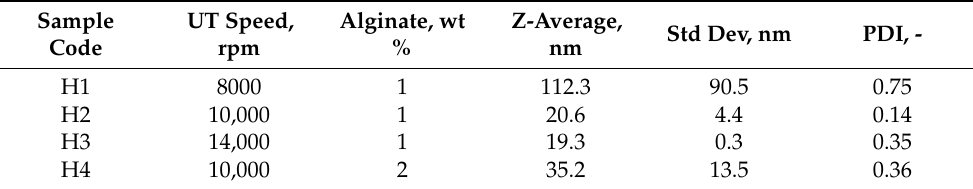
Table 3. Z-average and PDI evaluated by DLS on nanohydrogels prepared with increasing homoge- nization speed and with different amounts of sodium